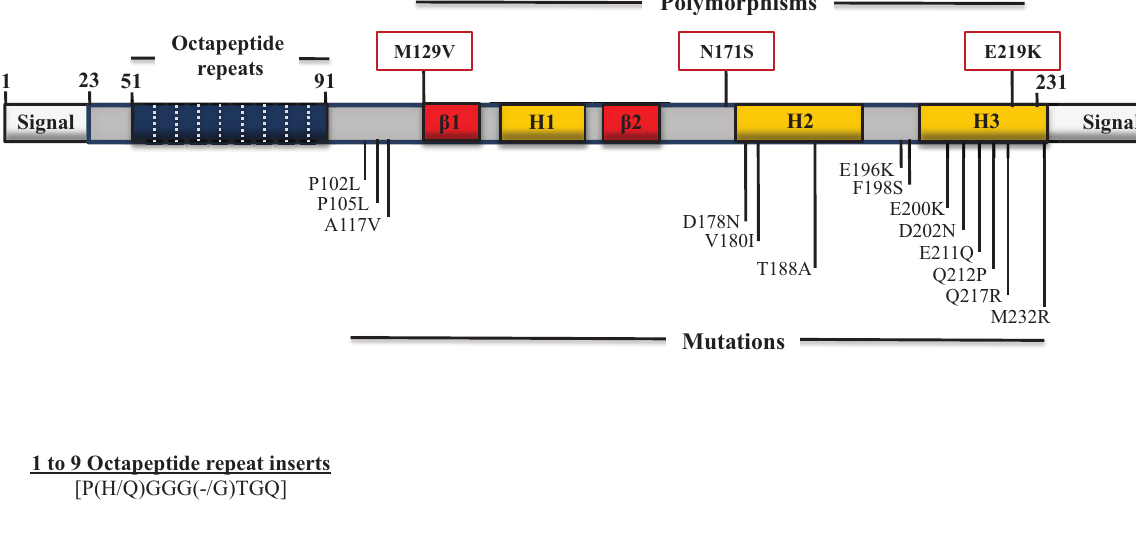
Figure 1. Schematic representation of human PrP mutations and polymorphisms. The 0.76 kb ORF of the PRNP gene encodes a 253 amino acid protein, PrP C . Human PrP consist of a cleaved signal peptide (1 – 22), an octapeptide repeat-containing unfolded domain (OR, 51 –91), three α -helices (H1, H2, and H3), one small, antiparallel β - sheet (β1 and β2), and a GPI-anchor signal (232 – 253). The N -terminal octapeptide repeat motif is comprised of eight residues: P(H/Q)GGG(-/G)WGQ. Normal PrP contains five copies of this motif;